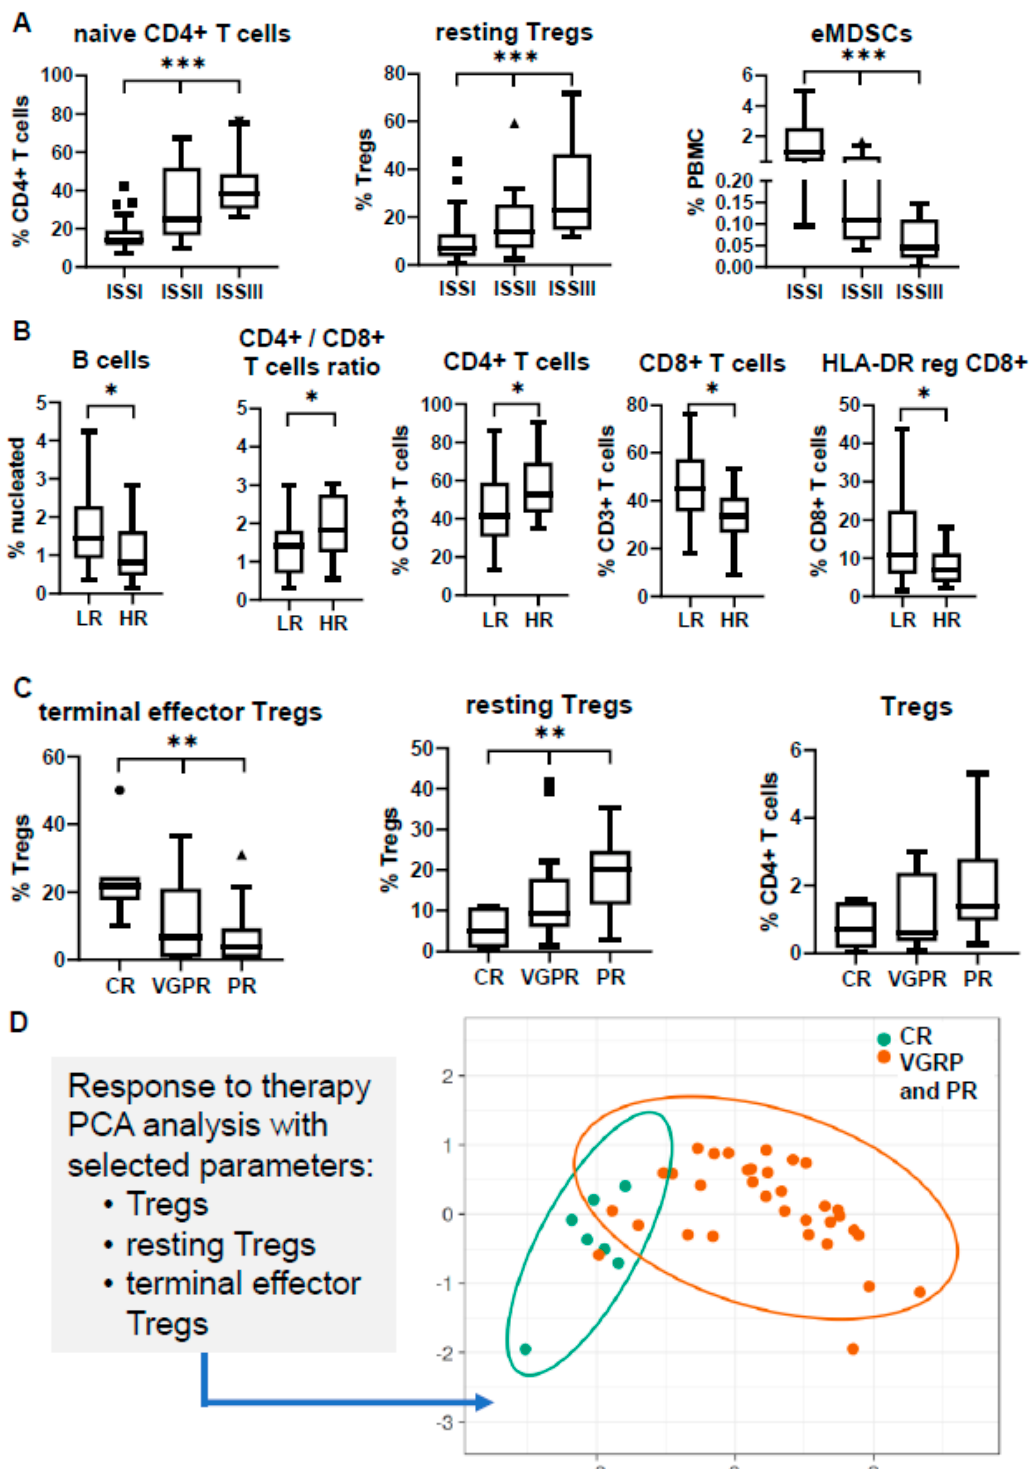
Figure 4. Peripheral blood (PB) profiling of different clinical and prognostic groups at the time of diagnosis. Comparisons refer to ( A ) International Staging System (ISS); ( B ) cytogenetics; ( C ) response to therapy; ( D ) PCA analysis of selected PB subsets according to therapeutic response. * p < 0.05; ** p < 0.01; *** p < 0.001; MDSCs: myeloid-derived suppressor cells; HR: high-risk; LR: low-risk; CR: complete response; VGPR: very good partial response; PR: partial response; PCA: principal component analysis.